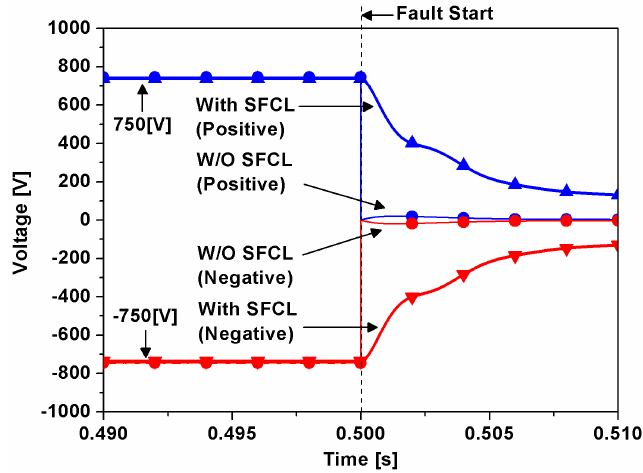
Figure 5. DC Voltage in LVDC system according to apply or not